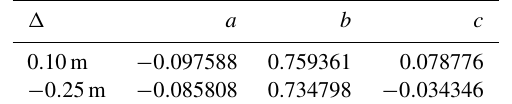
Table 9. Polynomial coefficients defining slide motion.